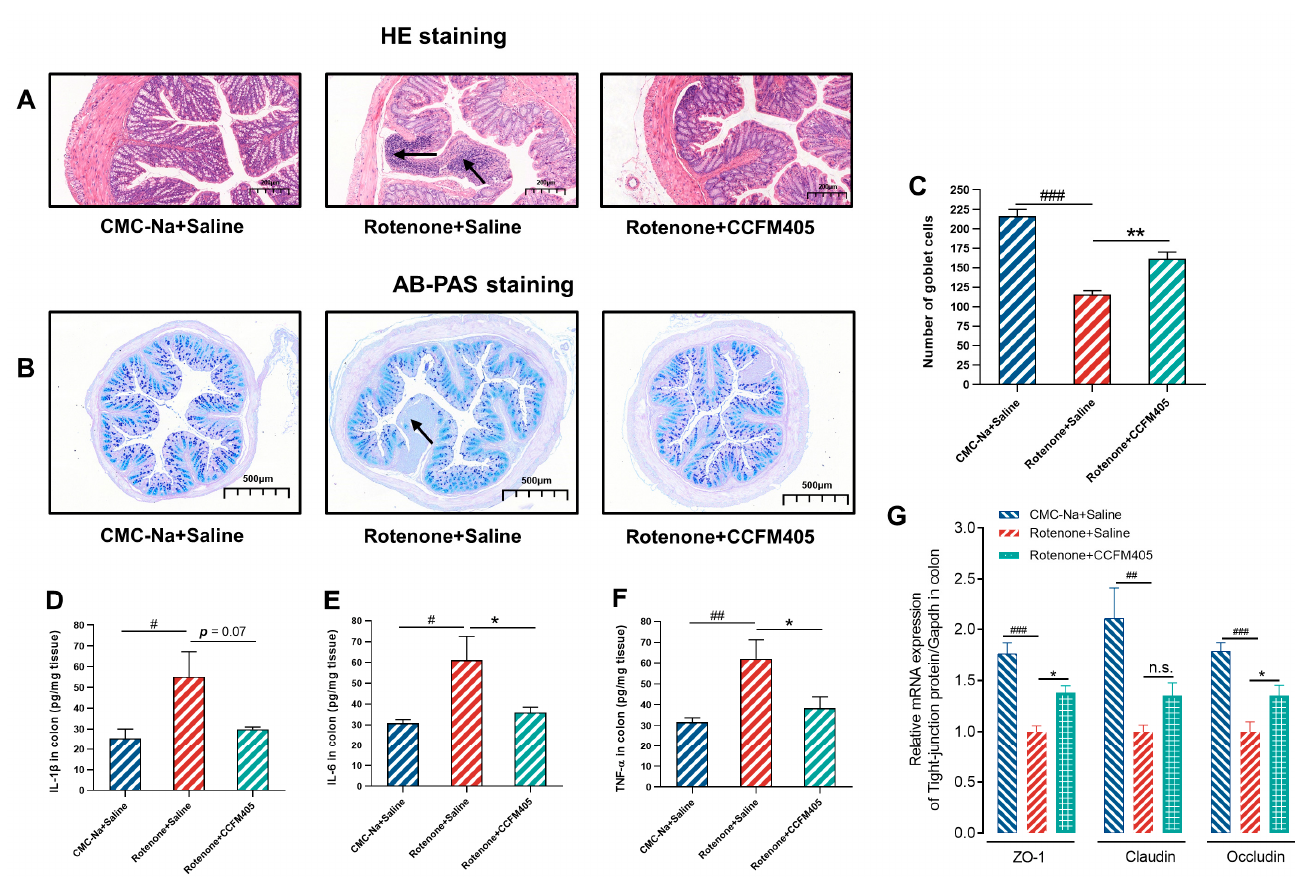
Figure 5. Effects of L. plantarum CCFM405 on intestinal inflammation and goblet cell count in the colon in rotenone-induced PD mice. ( A ) Representative images of H&E staining in the colon; the black arrows show inflammatory cell infiltration ( n = 3/group); ( B ) representative images of AB-PAS staining of the colon ( n = 5/group); ( C ) the number of goblet cells in the colon; ( D – F ) the concentra- tion of IL-1 β , IL-6, TNF- α in the colon ( n = 8/group); ( G ) relative expression of colonic tight junction protein mRNA ( n = 4/group). Data are means with SEM. # p < 0.05, ## p < 0.01, ### p < 0.001 signs Rotenone+Saline group vs. CMC-Na+Saline group; * p < 0.05, ** p < 0.01 signs Rotenone+CCFM405 group vs. Rotenone+Saline grup.